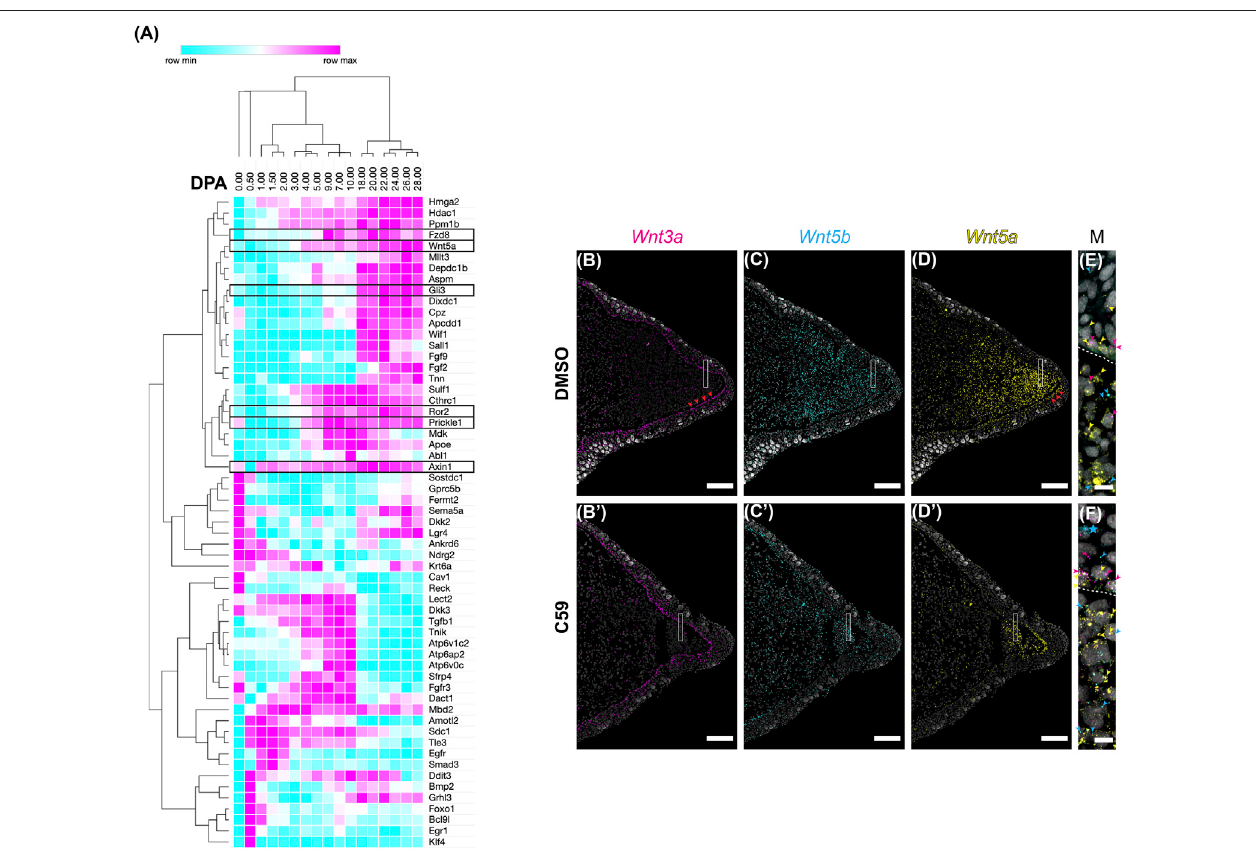
FIGURE 7 | Wnt ligand expression during limb regeneration. (A) Hierarchical clustering of 59 Wnt signaling genes during 28 days of limb regeneration. Days post amputationarepresented onthexaxis.Genesarepresented ontheyaxis.GenesevaluatedbyHCR-FISH arehighlightedwithboxes. (B – D) HCR-FISH wasperformed on a coronal section of a forelimb blastema at the mid bud stage, 20 dpa. C59 treatment started on 18 dpa. The few non-speci fi c dots located outside of the limb were removedfor clarity.Scale bars (B – D 9 ) are250 µm. (B) Wnt3a expression inthe mid blastema showingstrong expression inthebasalepidermis, highlighted byred arrowheads. Some mesenchymal expression is present in the mesenchyme (highlighted with magenta arrowheads in the merged image, (E) . (B 9 ) Wnt3a was minimally impacted from 48 h of C59 treatment. (C) Broad mesenchymal expression of Wnt5b . Few spots were observed in the epithelium. (C 9 ) Decreased Wnt5b expression in C59 treated limb with same expression pattern as (C) . (D) Wnt5a expression showing strong mesenchymal and basal epithelium expression higher near the distal blastema. Red arrowheads highlight expression in the basal epithelium. (D 9 ) Wnt5a expression retained only in the most distal mesenchyme and basal epithelium after C59 treatment. (E,F) Close-up images were adjusted for brightness and contrast and Gaussian blurred with a radius of 1. Dotted lines indicate the epithelial boundary. Scalebarsin (E,F) are20 µm. (E) Close-upmergedimageofboxedareain (B – D) showing Wnt3a , Wnt5b ,and Wnt5a expression.Magentaarrowheadshighlight Wnt3a expression, cyan arrowheads highlight Wnt5b expression, and yellow arrowheads highlight Wnt5a expression in a DMSO-treated limb. (F) Close-up merged image of boxed area in (B 9 – D 9 ) showing Wnt3a , Wnt5b , and Wnt5a in C59 treated limb. Blue star indicates an auto fl uorescent cell in the epithelium.